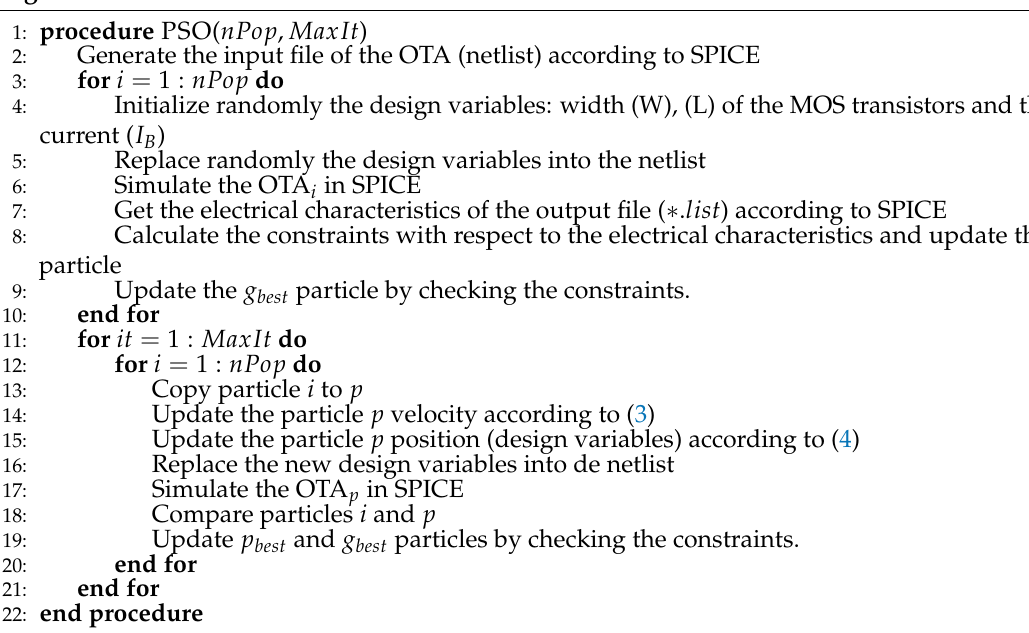
Algorithm 1 PSO